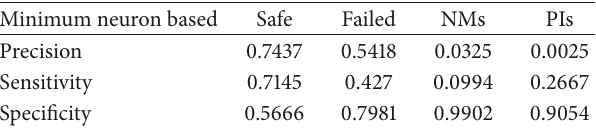
Table 3: Minimum neuron based SSSOM performances: precision, sensitivity, and specificity for each class.